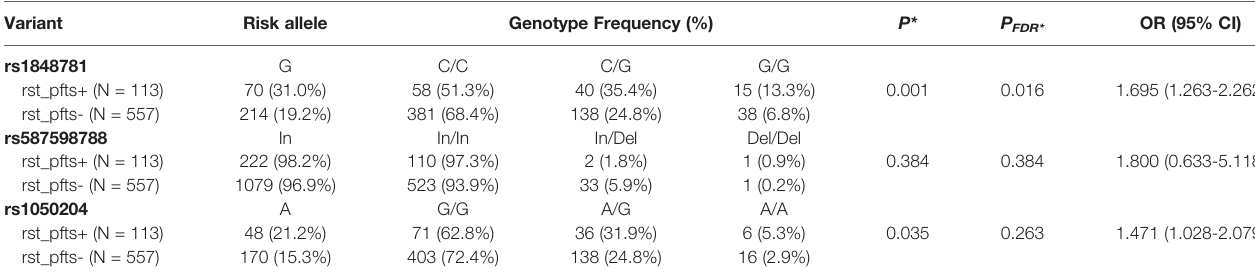
TABLE 4 | Association of FCGRIA variants with poor lung function among sarcoidosis patients. Variant